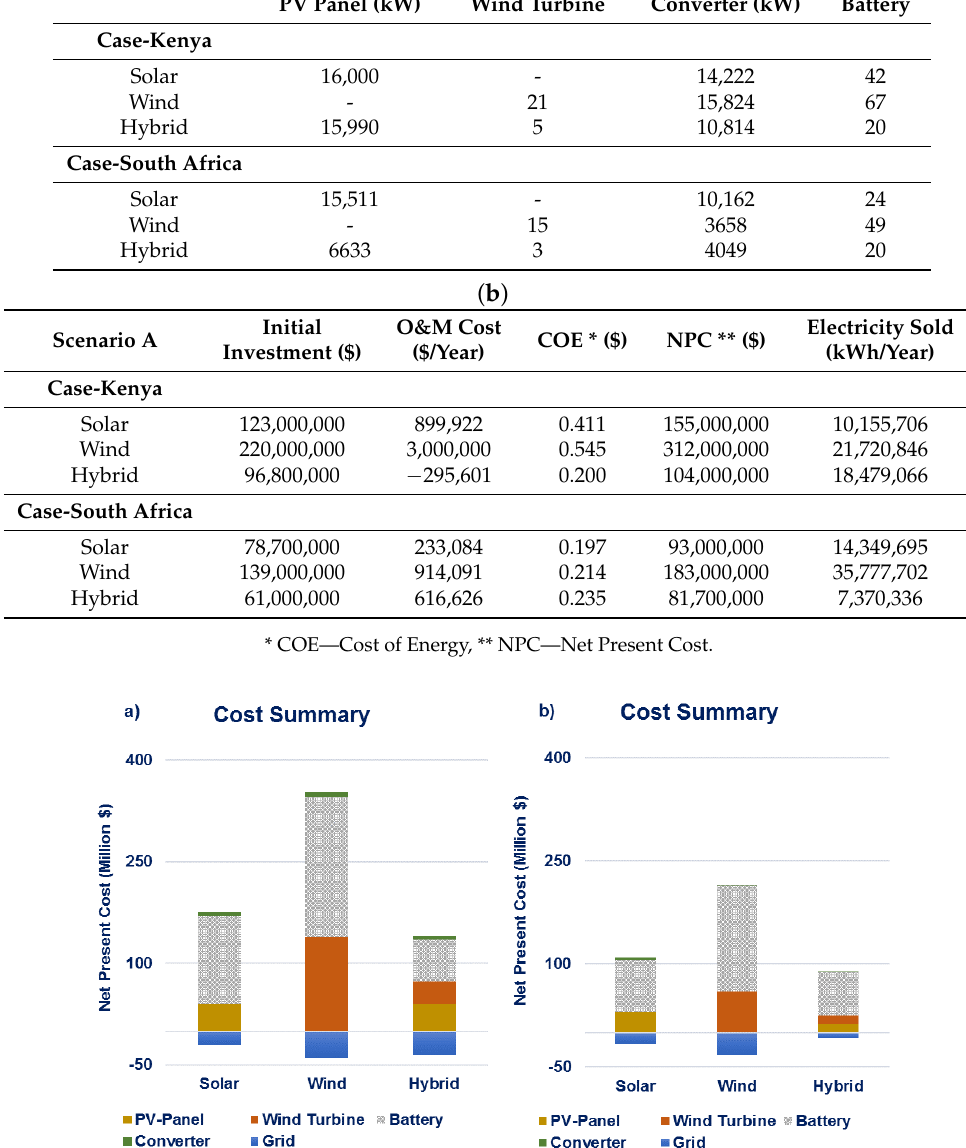
Table 3. ( a ) Optimized configurations of the examined renewable power systems for scenario A; ( b ) Economic results of optimized configurations of the examined renewable power systems for scenario A.